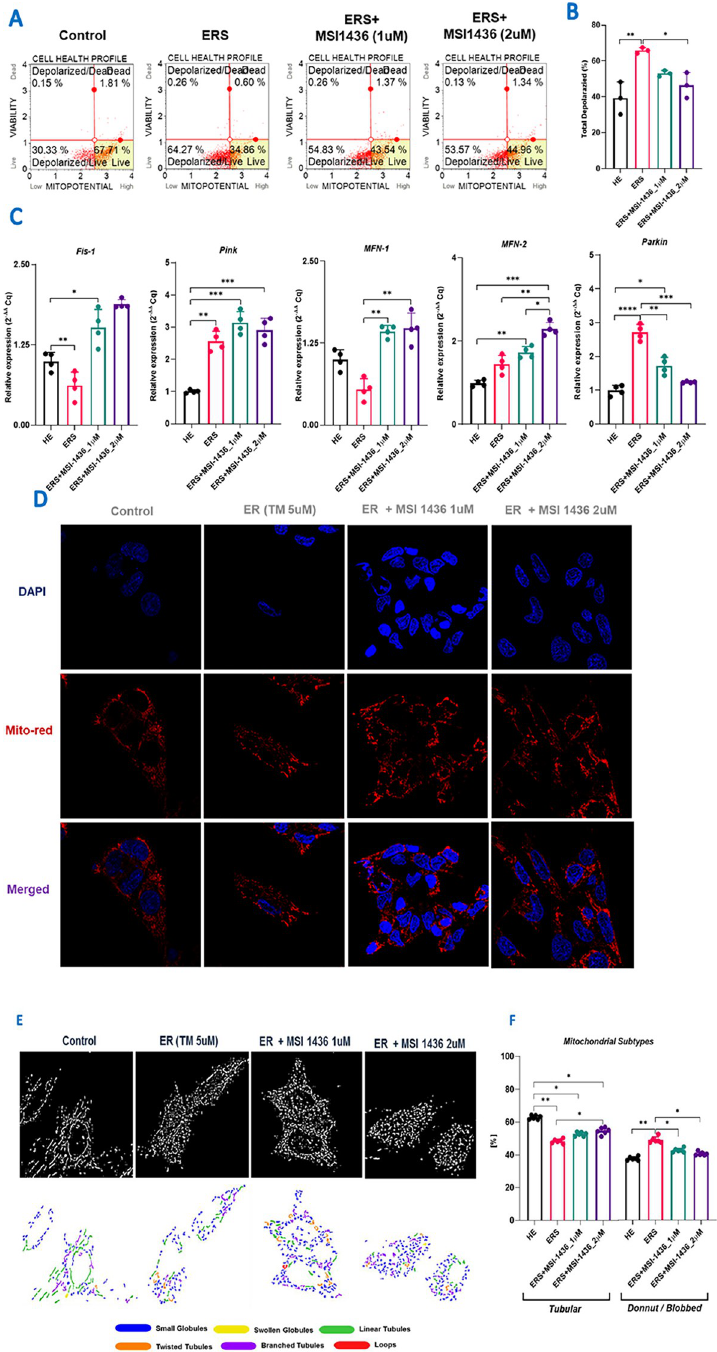
Fig 3. MSI-1436 improves mitochondrial dynamics in TM-challenged HepG2 cells. ( A ) Flow cytometry analysis on mitochondrial membrane potential profile. (B) Histogram representing the percentages of depolarized cells. (C) Histograms summarizing the relative expression of genes implicated in mitochondrial dynamics. ( D ) Confocal photomicrographs for Mitochondrial network stained with fluorescent Red MitoTracker. (E) Mitochondrial Network morphology analysis. (F) Bar charts depicting the percentage of tubular (including Linear, Twisted and Branched Tubules) and blobbed (including small/swollen globules and loops) mitochondria in each group of cells. The results are expressed as the mean of 3 different experiments ± SD. Asterisks refer to a significant difference between two groups, where: p < 0.05 ( � ); p < 0.01 ( �� ); p < 0.001 ( ��� ); p < 0.0001 ( ���� ). HE: Healthy untreated HepG2 cells; ERS: Endoplasmic reticulum-stressed cells; ERS+MSI: Groups pretreated with MSI-1436 compound before inducing ERS.